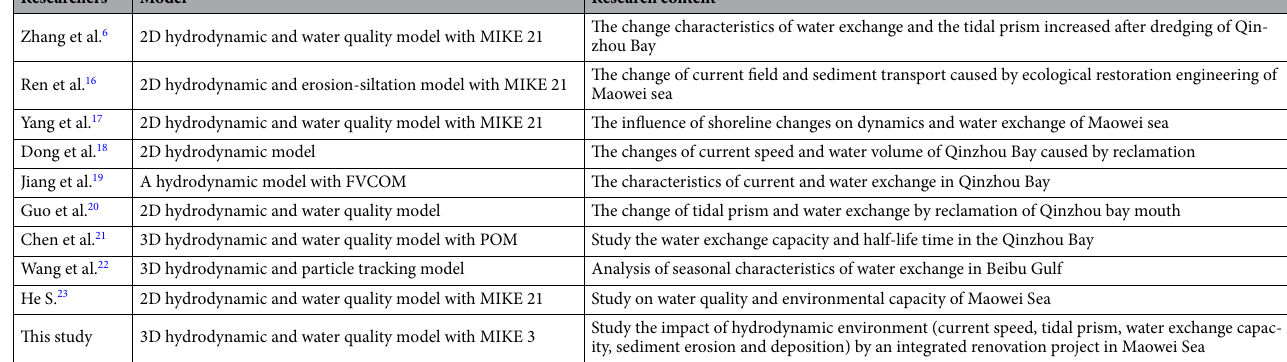
Table 1. Comparison of the numerical models used in the Maowei